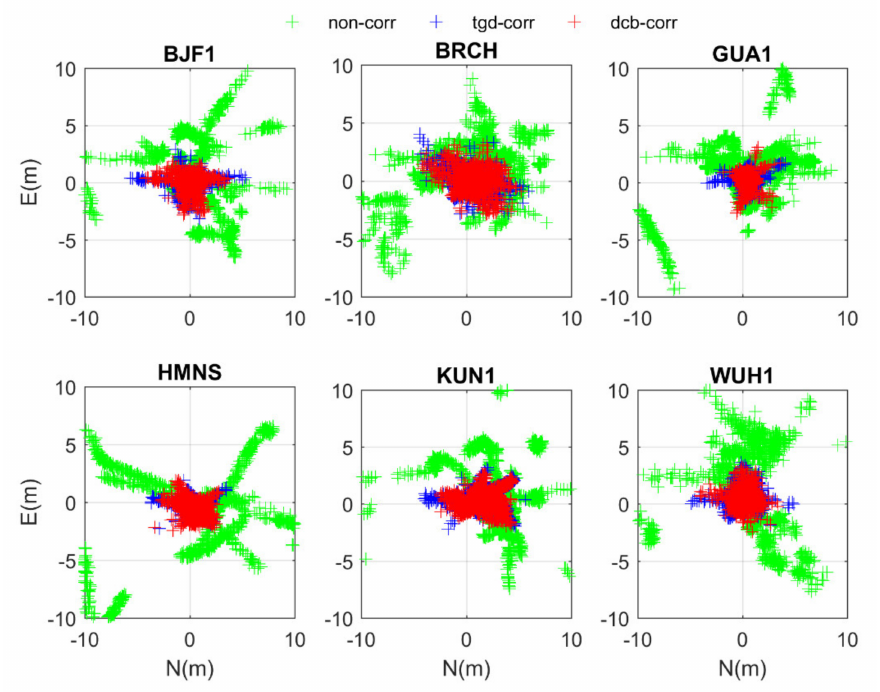
Figure 5. Horizontal positioning error scatters with and without TGD or DCB correction of B1I SPP at six stations.